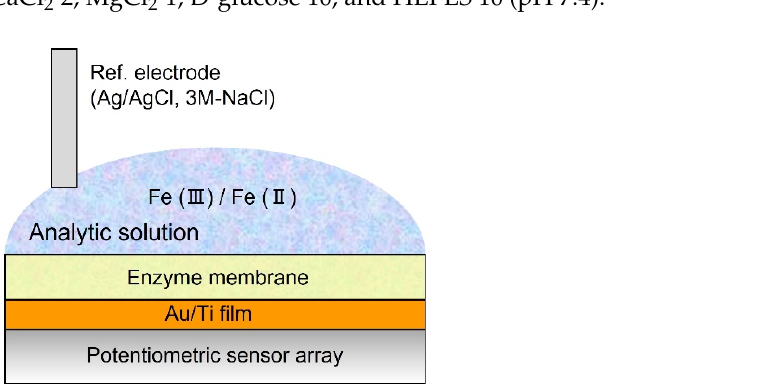
Figure 2. Schematic illustration of a cross − sectional view of measurement setup for redox re-